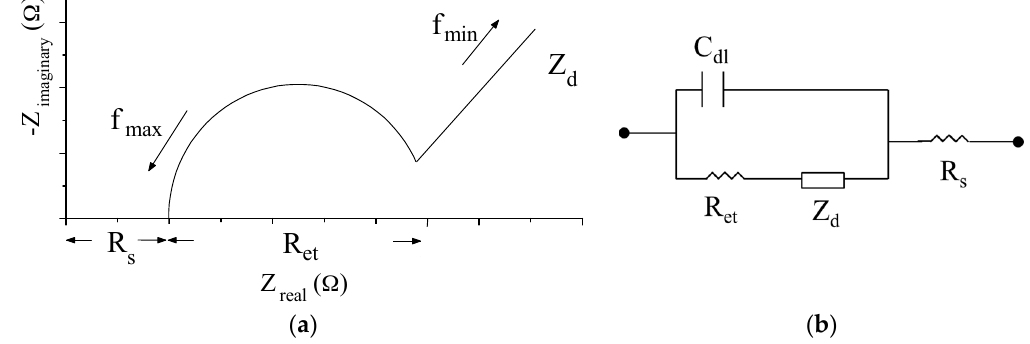
Figure 6. ( a ) The Nyquist diagram and ( b ) its equivalent circuit for biosensor.